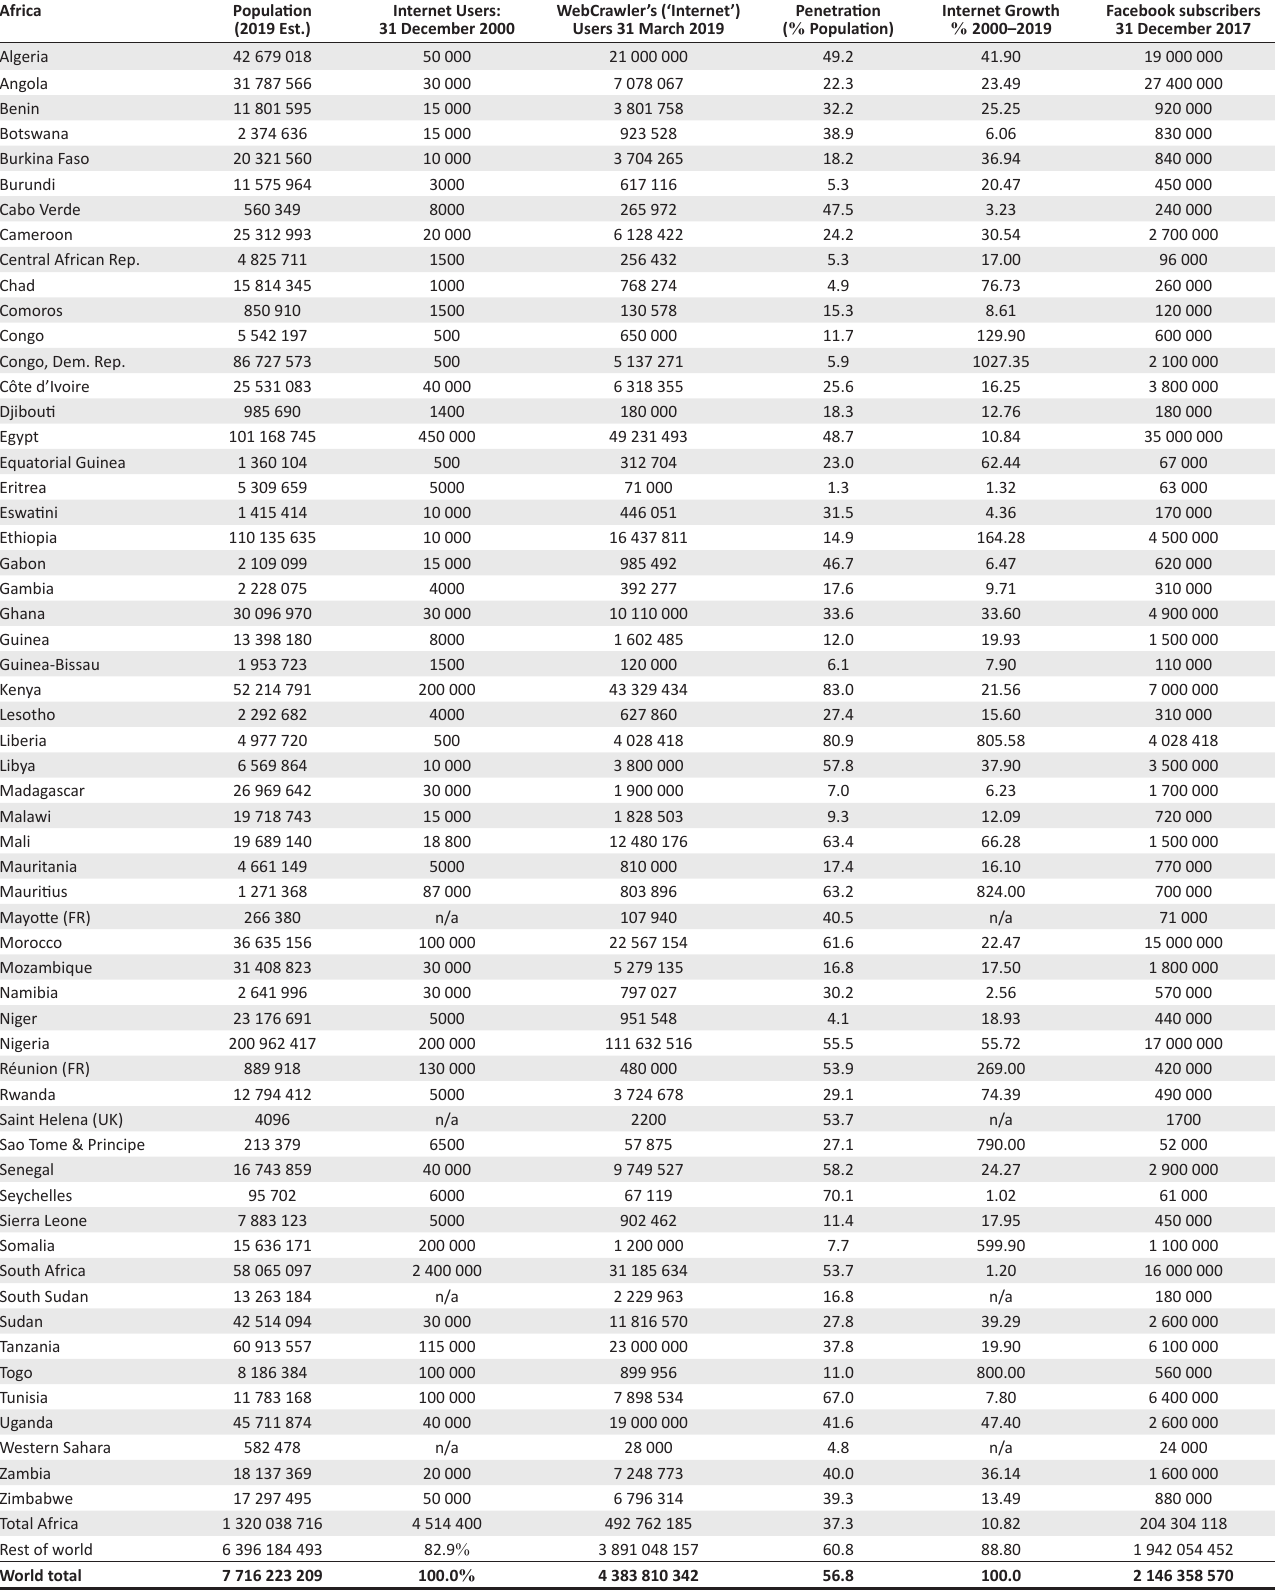
TABLE 1: Internet users Statistics for Africa: Africa 2019 populace and WebCrawlers user statistics. Africa Population (2019